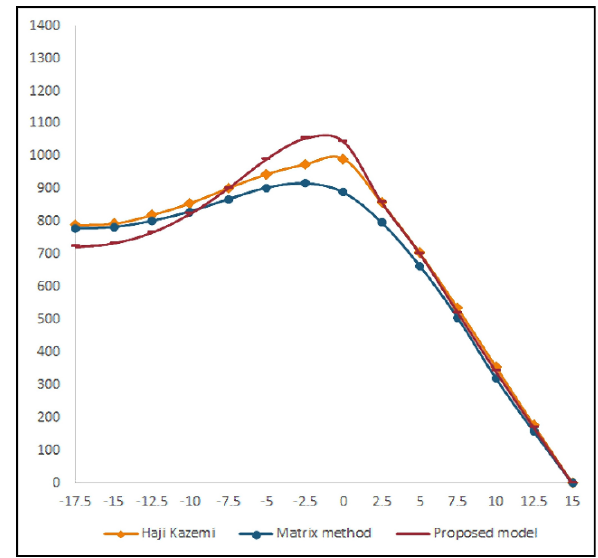
Figure 11. Axial force distribution in the flange and web columns at the 10th floor of the